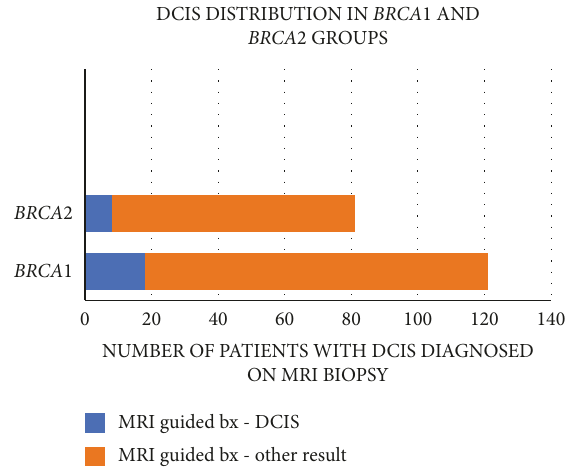
Figure 1: BRCA patients that underwent MRI-guided biopsy; part of them had the diagnosis of DCIS on MRI biopsy divided by